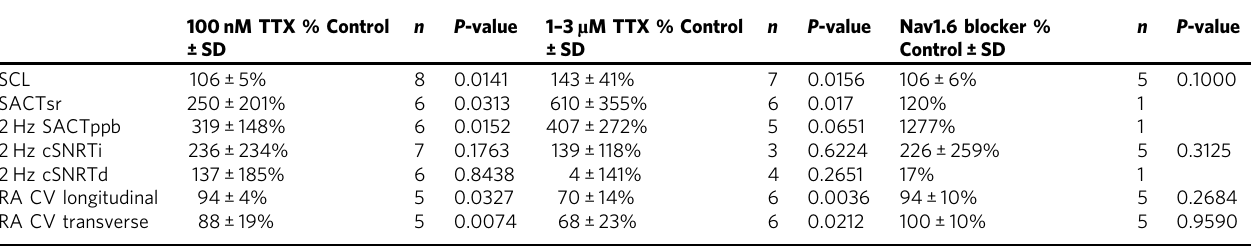
cSNRTd/i correcteddirect/indirectsinus noderecovery time, RA rightatrial, SACTsr/ppb sinoatrial conductiontime at sinusrhythm/post-pacingbeat, SAN sinoatrial node, SCL sinuscyclelength. Percent data are reported as mean±SD. Normality assumption was veri fi ed using Shapiro – Wilk test. Parametric data were analyzed with two-sided t -test. Non-parametric data were analyzed with two-sided Wilcoxon ’ s test. Source data are provided as a Source Data fi